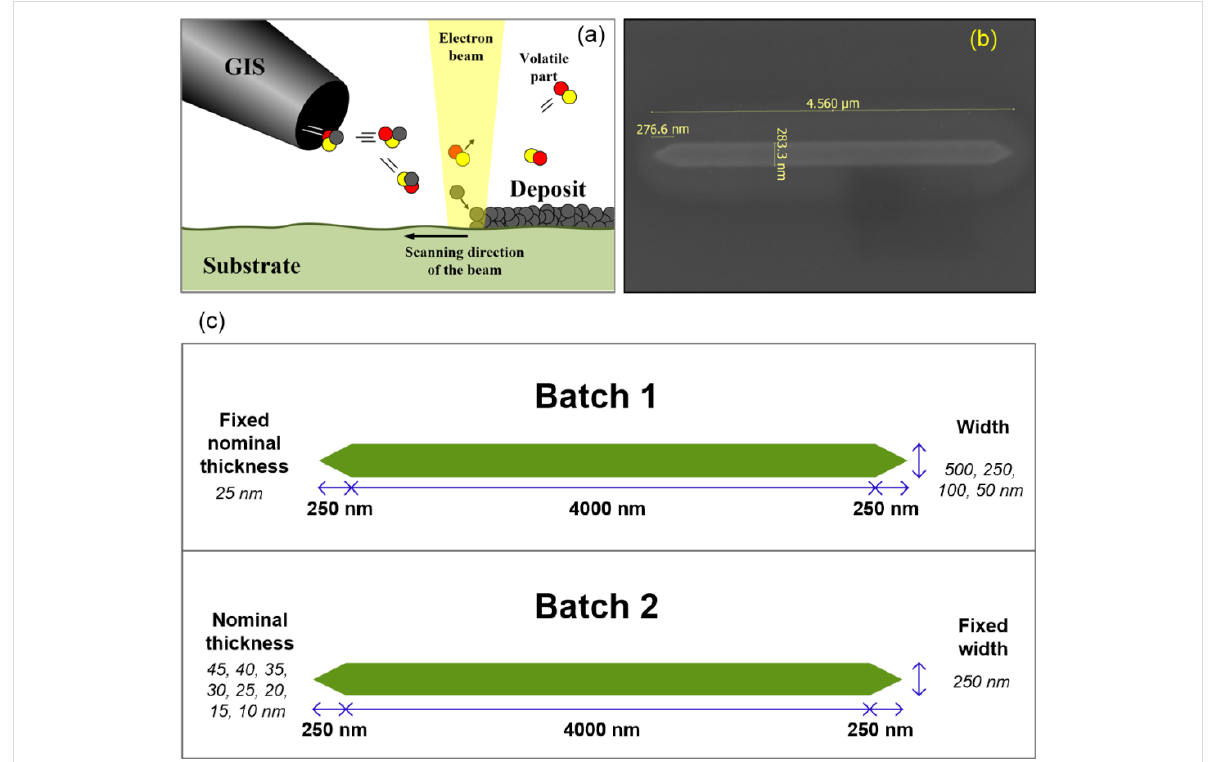
Figure 1: (a) A sketch of the FEBID process. (b) A SEM image of the nanowire with targeted width of 250 nm and nominal thickness of 15 nm. (c) Sketch of the two batches of nanowires: Batch 1 has got 25 nm nominal thickness and varying width whereas batch 2 has got 250 nm width and varying